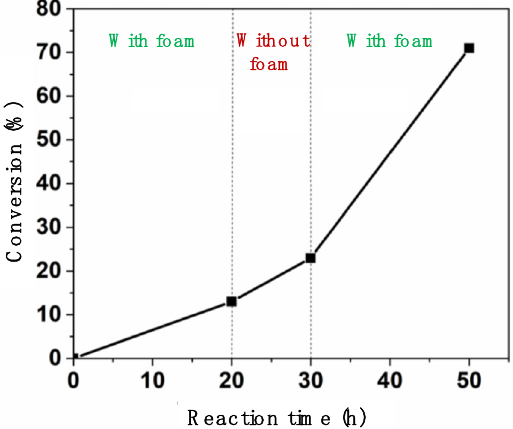
Figure 8. Filtration test on p -tolyl methyl sulfide oxidation with EY-APTES@PDA@PUF. Reaction conditions: methyl p -tolyl sulfide (0.5 mmol), EY-APTES@PDA@PUF (2 cm × 2 cm × 2 cm, 0.18 mol% EY), CH 3 CN/H 2 O (4:1) (20 mL), 24 W white LED, O 2 balloon, 30–35 °C, 1000 rpm.